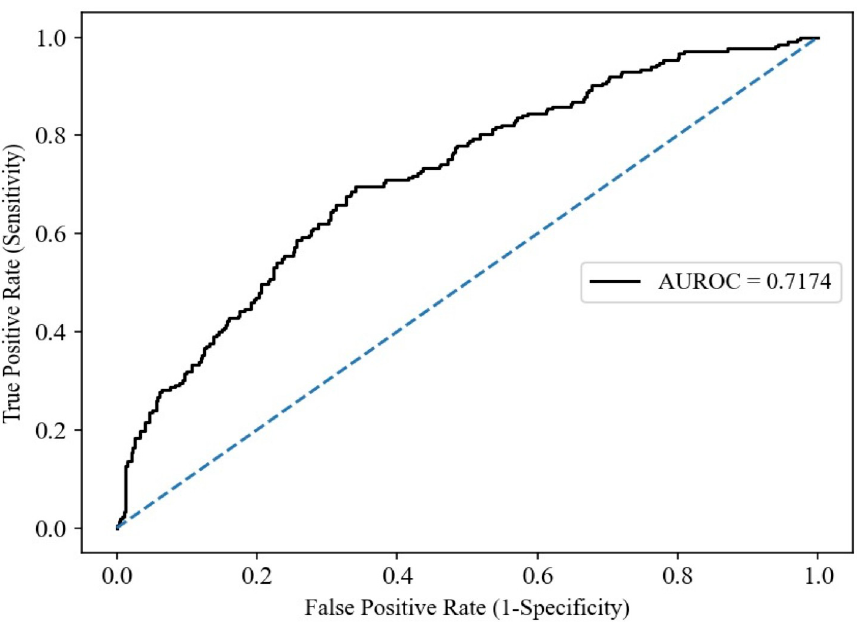
Fig 2. AUROC for prediction of non-attendance at ppGT. AUROC was used to evaluate the performance of our machine learning based algorithm using logistic regression model on the validation cohort, n = 607 by aggregating the predictions from the 5 test folds of CV1. The area under ROC was 0.72. The dotted line indicates optimal threshold. The grey line indicates ‘target none’ approach and black line indicates ‘target all’ approach. The blue line indicates the net benefit of the proposed ML prediction model.